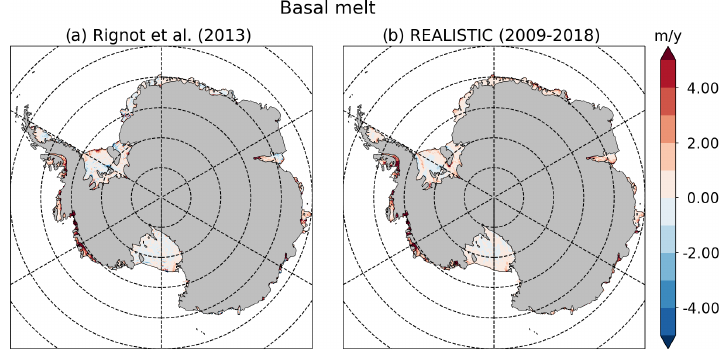
Figure B3. Comparison between basal melt patterns (in metres per year) from Rignot et al. (2013) and an average of our REALISTIC simulation between 2009 and